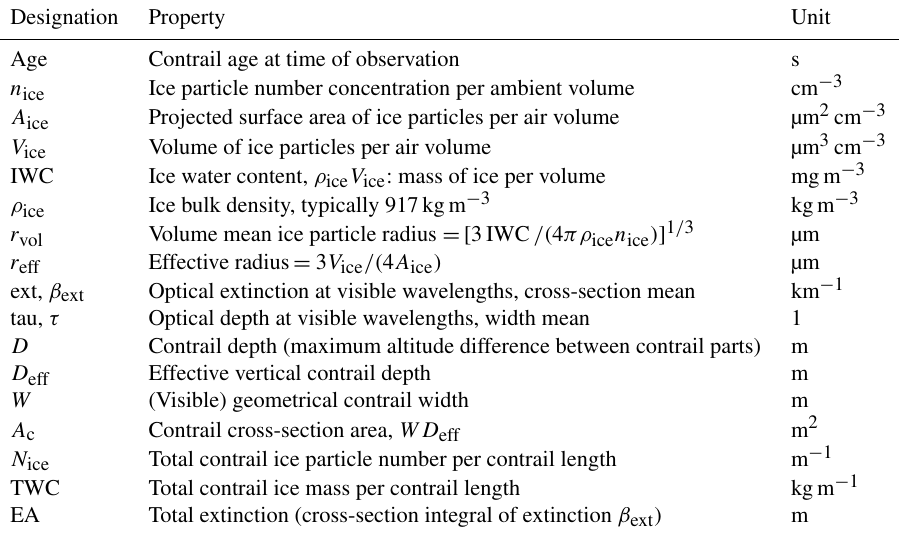
Table 6. Contrail